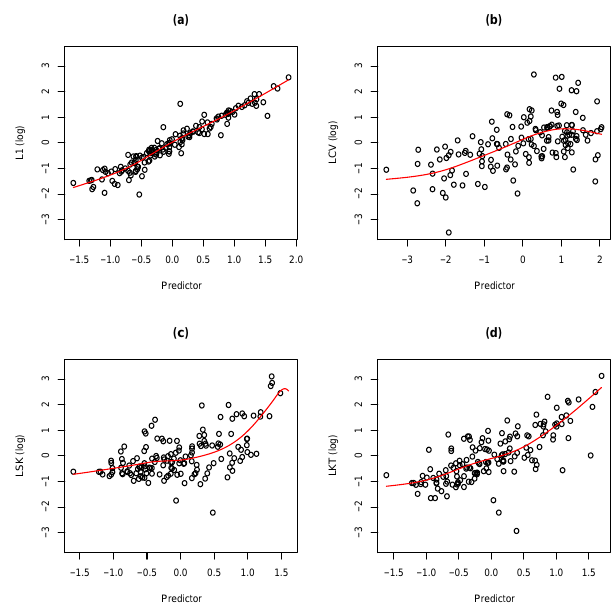
Figure 4. Residuals of the reference variables by PPR methods.